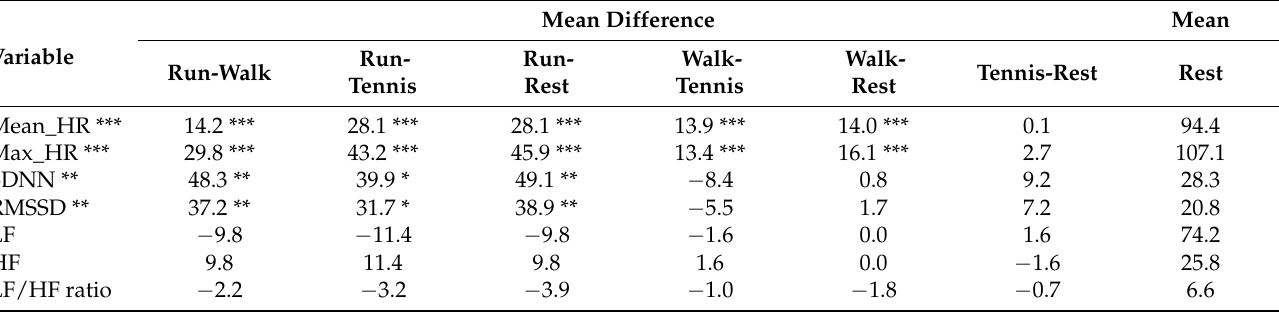
Table 4. Multiple comparison of effects of exercise types on ECG